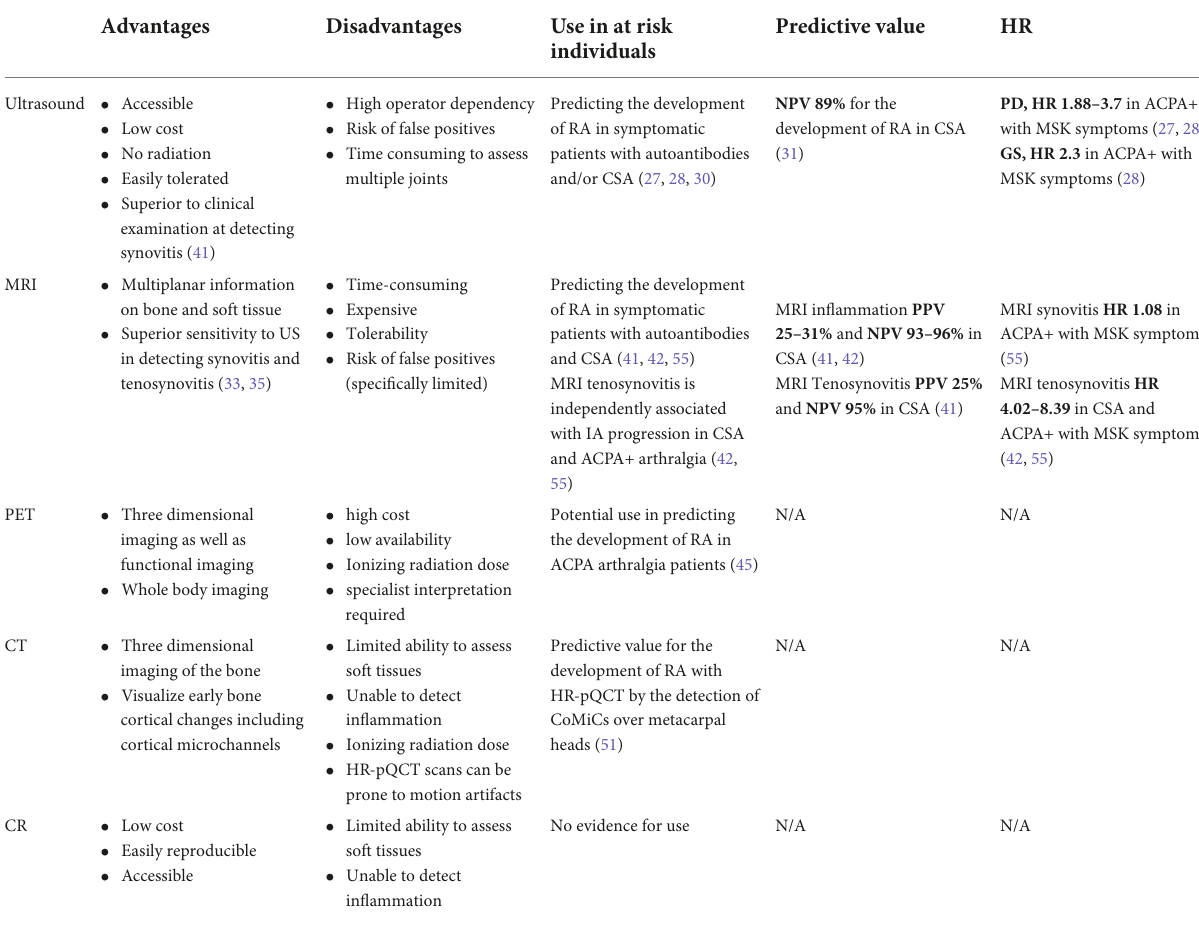
TABLE 2 A summary of the advantages and disadvantages of different imaging modalities and the evidence for the use in individuals at risk of RA. Summary of imaging